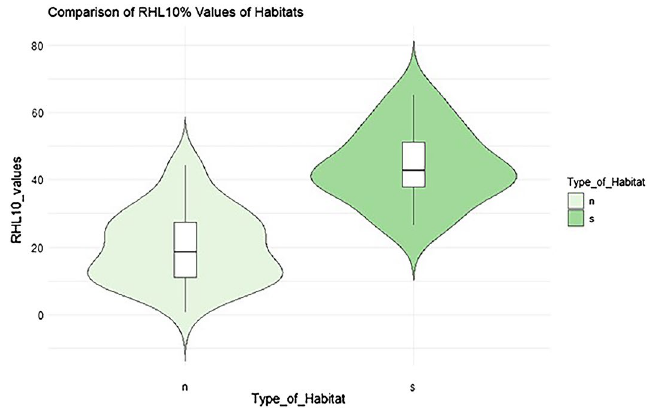
Figure 6. Differentiation of RHL 10% of selected forest types in the B04-Red optical band intensity value in August (dataset from August 31, 2019). On the vertical axis are values of RHL. The P value is less than 0.001.